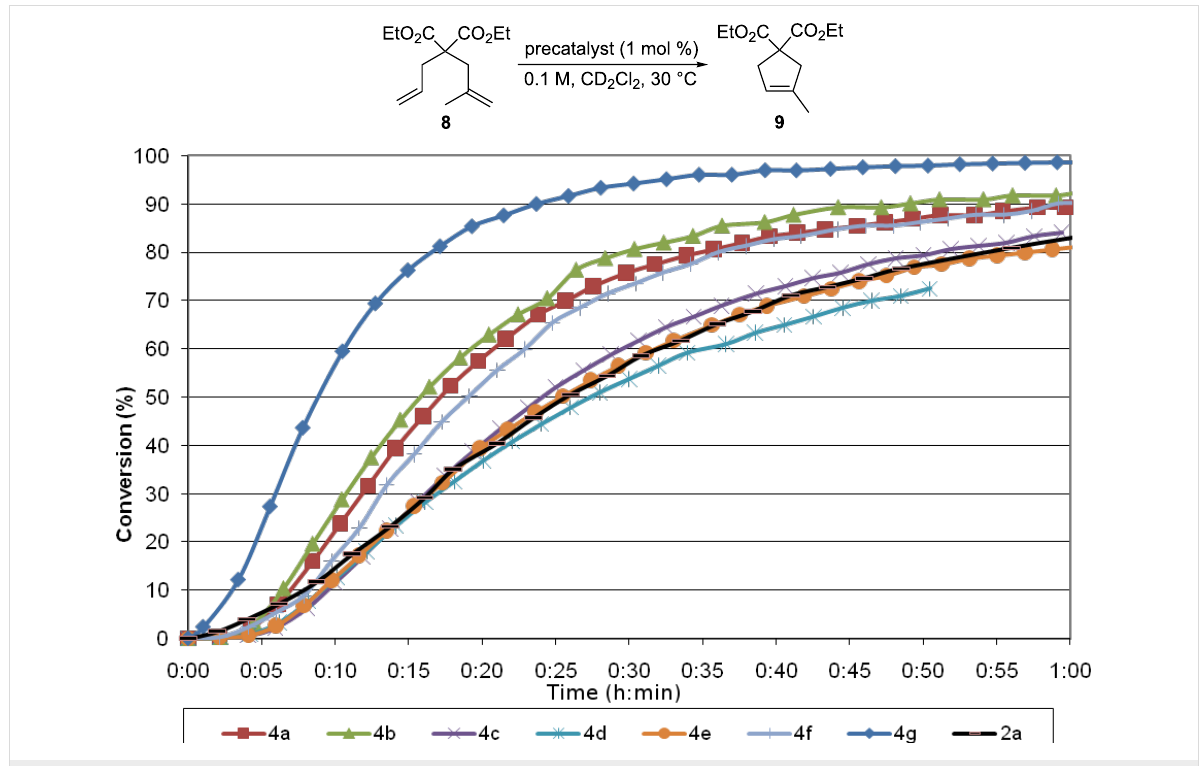
Figure 3: Kinetic studies of RCM of 8 (0.1 M) with precatalysts 4a – g (1 mol %) in CD 2 Cl 2 at 30 °C.